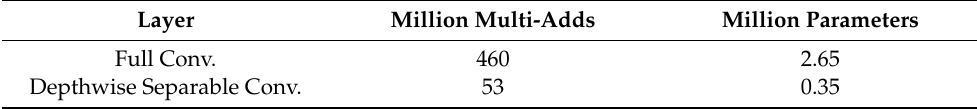
Table 5. The number of parameters for the layers. Layer Million Multi-Adds Million Parameters Full Conv. 460 2.65 Depthwise Separable Conv. 53 0.35